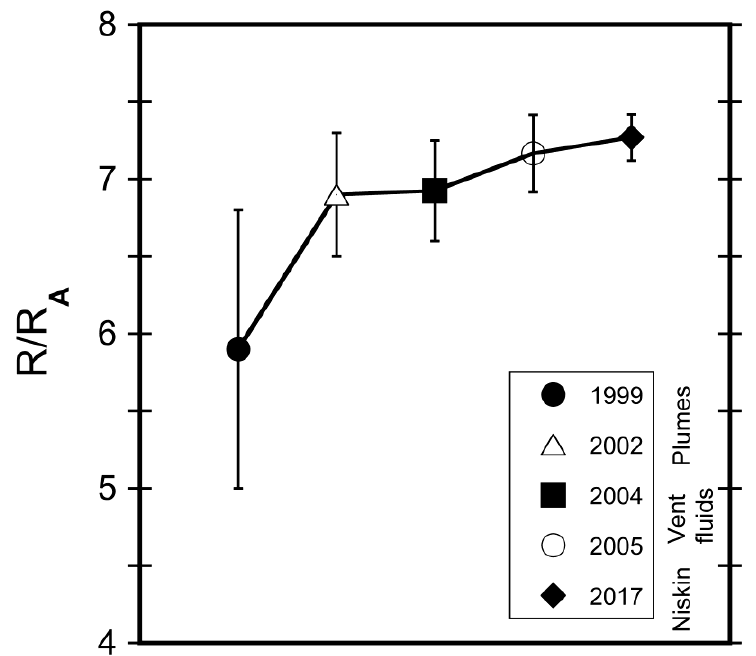
Figure 7. Brothers NW caldera end member fluid He isotope composition expressed as a factor of the atmospheric 3 He / 4 He ratio (R / R A ). The figure is modified from de Ronde et al. [15]. Data for 1999 and 2002 were estimated based on plume samples, 2004 and 2005 ratios were directly measured in end member samples and the 2017 ratio is extrapolated from Niskin bottle samples (see Section 3).